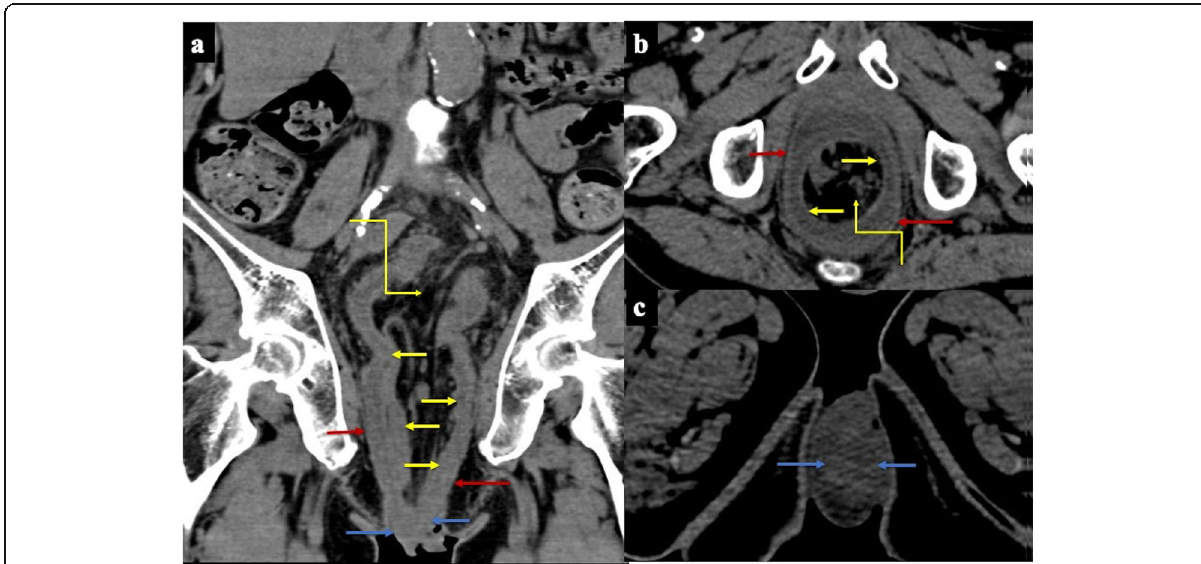
Fig. 3 a – c Coronal and axial non-contrast-enhanced computed tomography (NCCT) images showing intussusception of sigmoid colon (yellow arrows) with its mesentery (curved yellow arrows) into the rectum and anal canal (red arrows) with probable mass lesion as lead point at its tip (blue arrows)